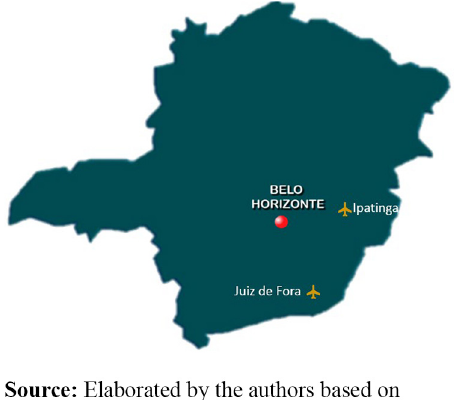
Figure 8. Illustrative map of airports that underwent or